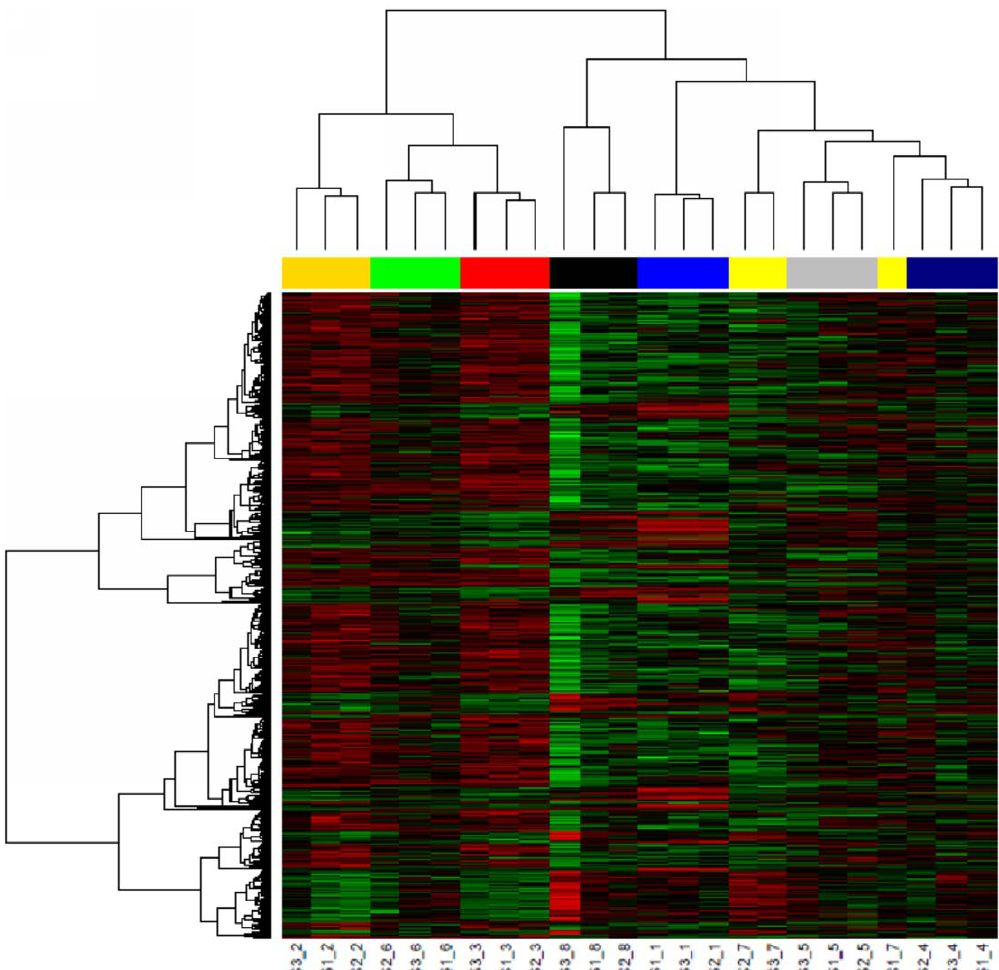
Figure 5. Hierarchical clustering of leukocytes-associated genes across samples exhibiting significant inter-individual differences. The expression profiles of 1893 leukocytes-associated genes across 24 samples were used for unsupervised hierarchical clustering. On the heat map, each row represents one gene and each column represents one patient. Red colour indicates gene over-expressed and green colour indicates gene low-expressed. Colours of bars associated with clustering of the columns designate samples from different donors. The leukocytes-associated genes perfectly cluster individual samples, suggesting the predominating effect of individual heterogeneities of leukocyte subsets on the blood gene expression profiles.